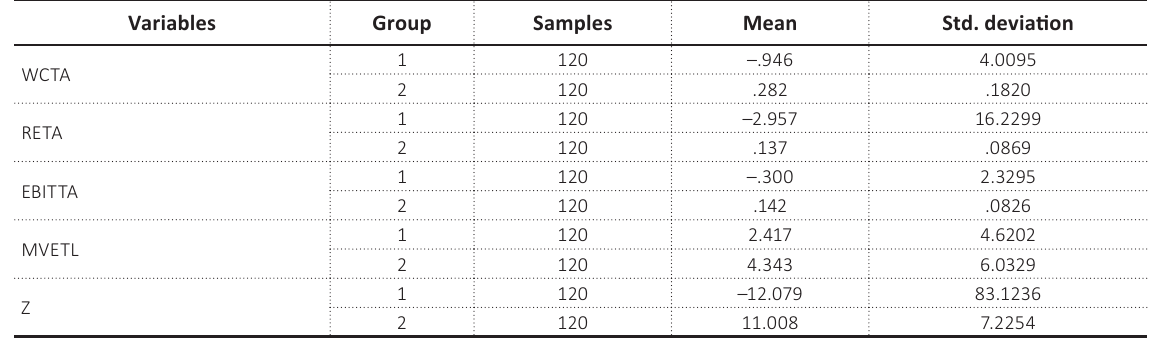
Table 1. Descriptive statistics of Group 1 and Group